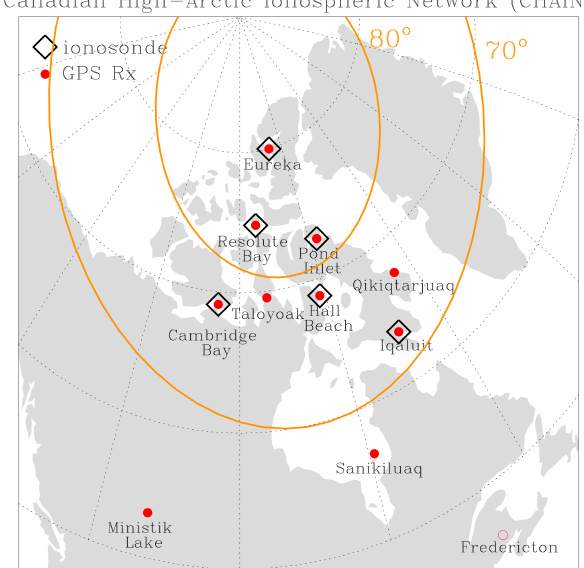
Figure 1. Canadian High Arctic Ionospheric Network (CHAIN): the GPS Ionospheric Scintillation and TEC Monitors and Canadian Advanced Digital Ionosondes (CADIs). The corrected geomagnetic (CGM) latitudes 70 and 80 ◦ , in yellow, are superposed over the ge- ographic